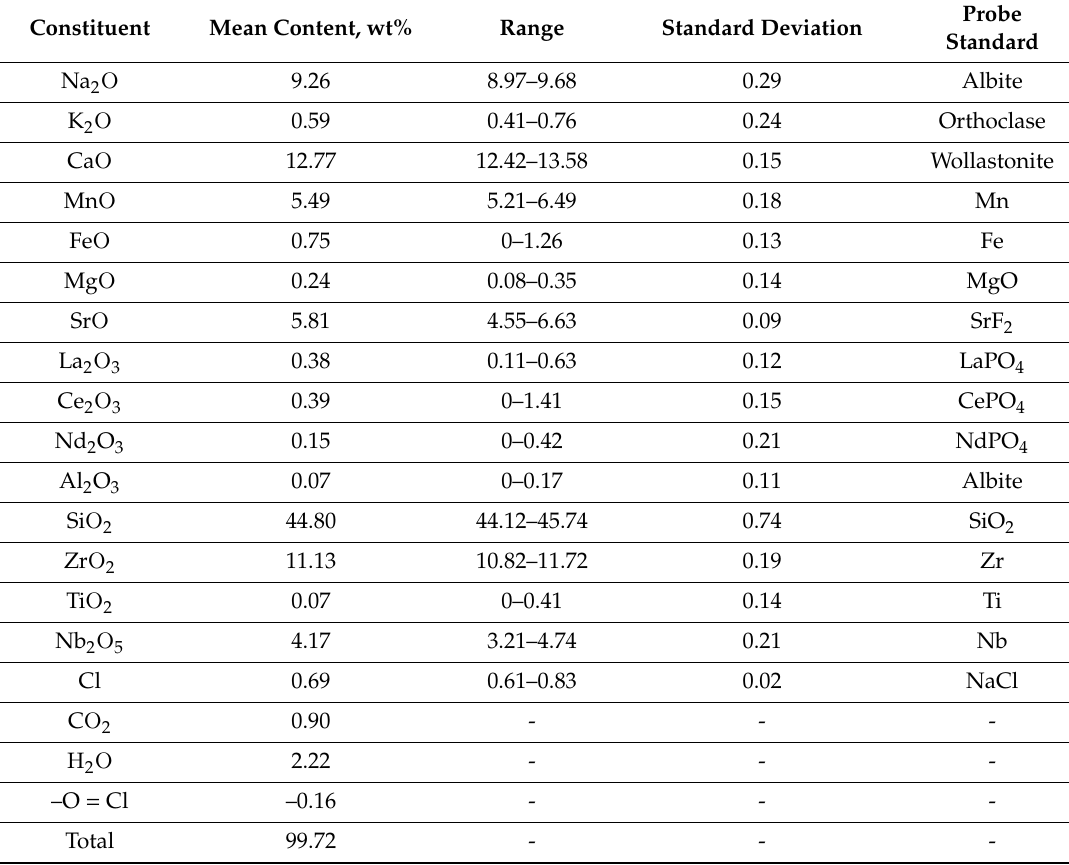
Table 2. Chemical data for odikhinchaite.